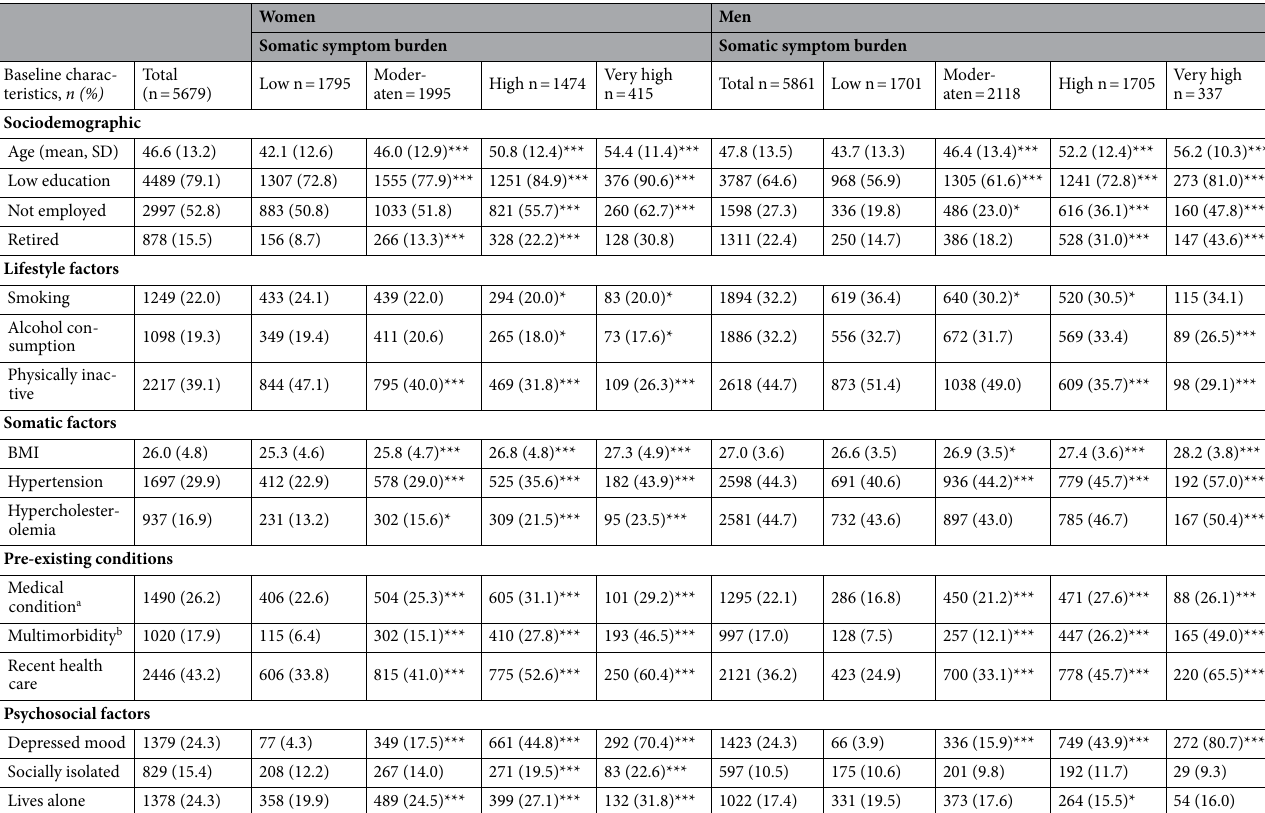
Table 1. Baseline characteristics of women (n = 5679) and men (n = 5861) according to somatic symptom burden in the MONICA/KORA population (N = 11,540). a 1 pre-existing medical condition. b ≥ 2